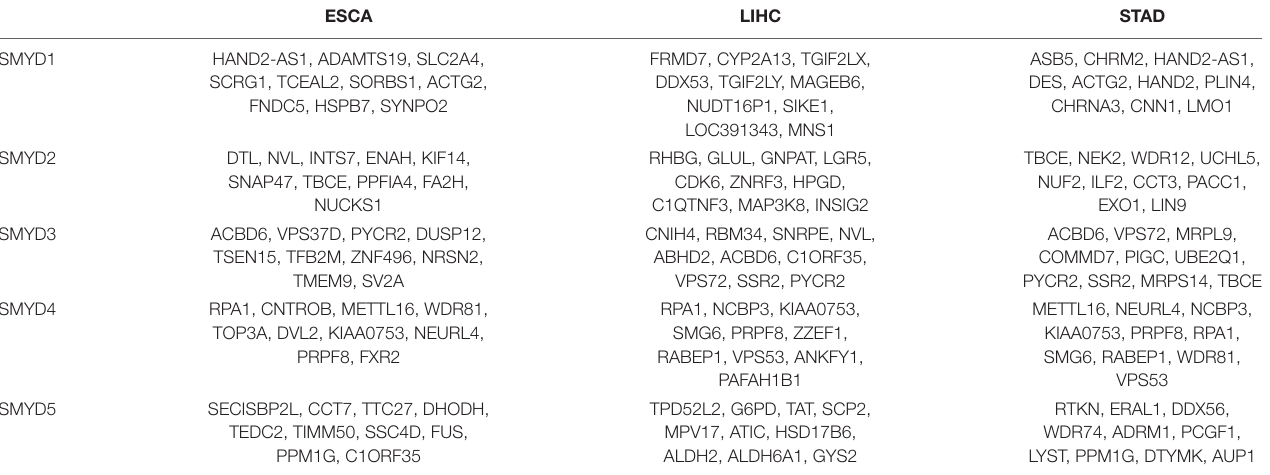
FIGURE 5 | Mutation of SMYD family members in ESCA, LIHC, and STAD patients (cBioPortal). A visual summary of mutation frequency of SMYD family members (A–C) . Summary of mutation frequency of SMYD family members in ESCA, LIHC, and STAD patients (D) . Kaplan–Meier plotter was used to compare the relationship between gene mutation (red) and gene non-mutation (blue) of SMYD family members and OS and PFS (E–G) ( P < 0.05 with statistical significance). TABLE 2 | The top 10 ESCA, LIHC, and STAD genes significantly associated with SMYD family mutations (cBioPortal). ESCA LIHC